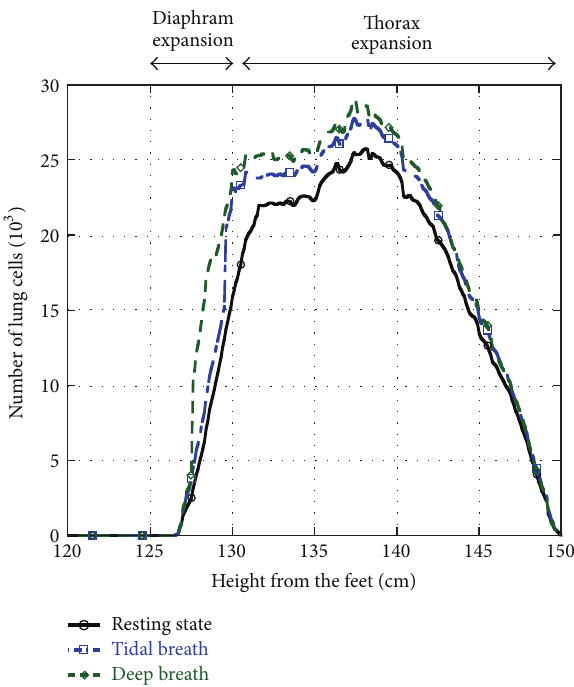
Figure 1: Number of lung cells, in the transversal plane, for the RS, TB, and DB models, as a function of the height from the feet.